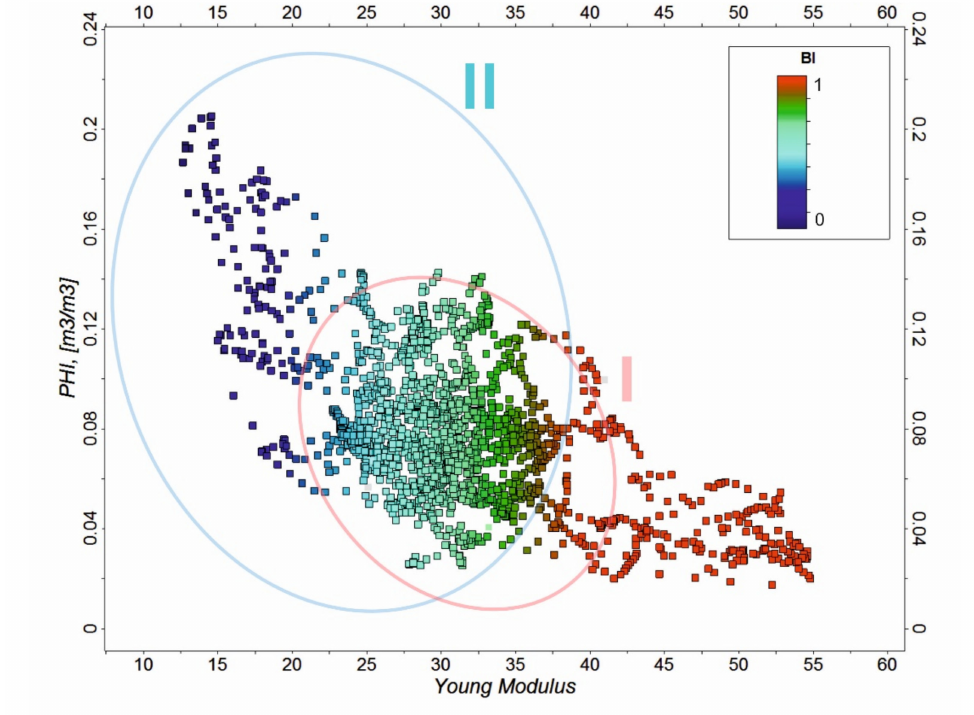
Figure 11. Young’s modulus vs. porosity (PHI; ϕ ) as a function of BI within Source I (red circle) and Source II (blue circle).